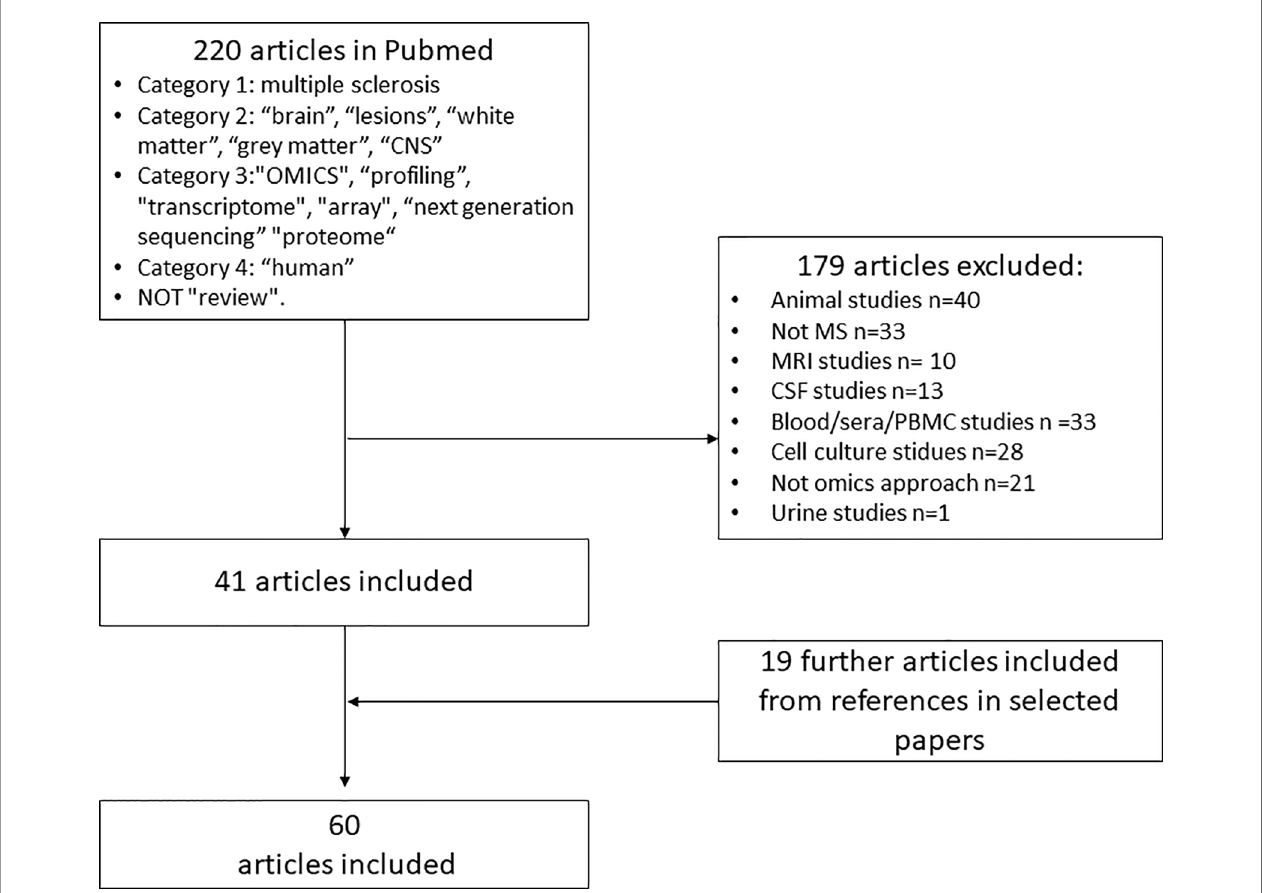
FIGURE 2 | Flowchart for identi fi cation and inclusion of relevant studies for systematic review. PMD, postmortem-delay; RIN, RNA integrity